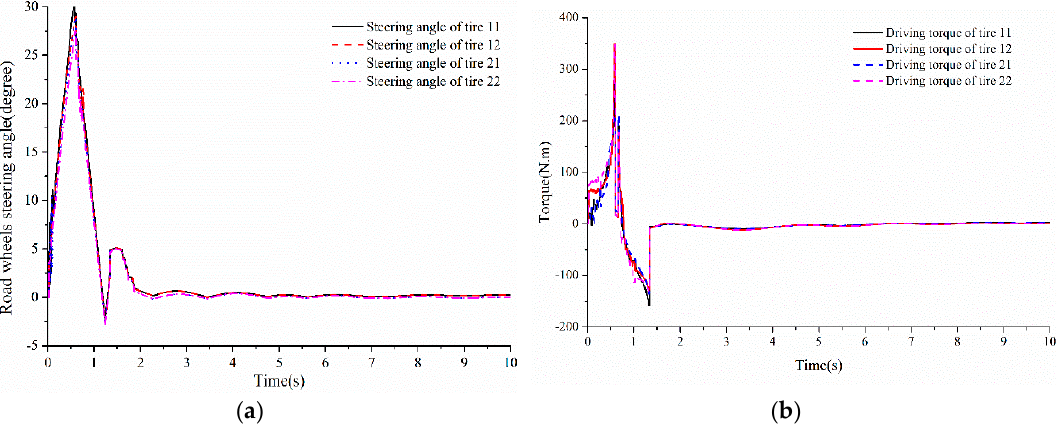
Figure 13. Curves of driving torques and steering angles of FWIDSV: ( a ) The curves of driving torque; and, ( b ) The curves of steering angles.